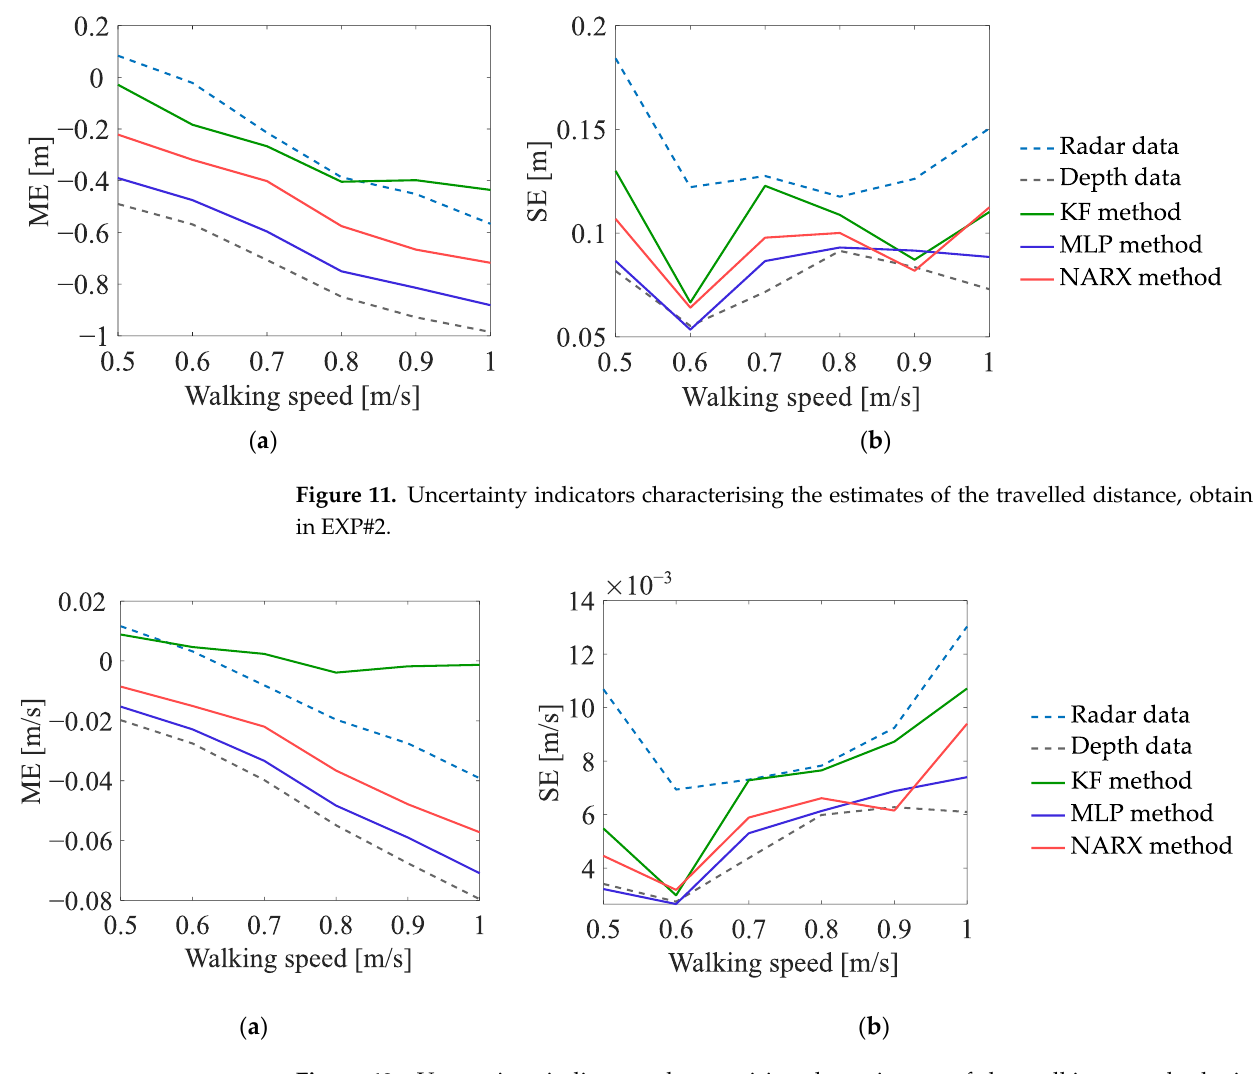
Figure 12. Uncertainty indicators characterising the estimates of the walking speed, obtained in EXP#2.